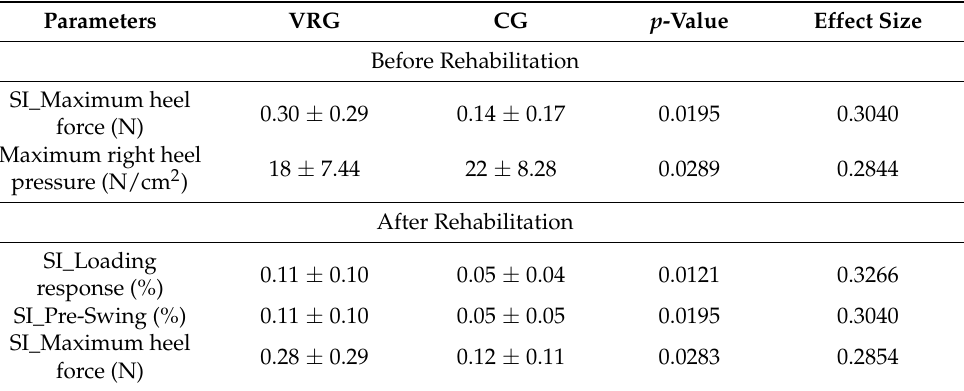
Table 3. Results (mean ± SD) of the Mann–Whitney U test ( p < 0.05) for comparison between the VRG and control